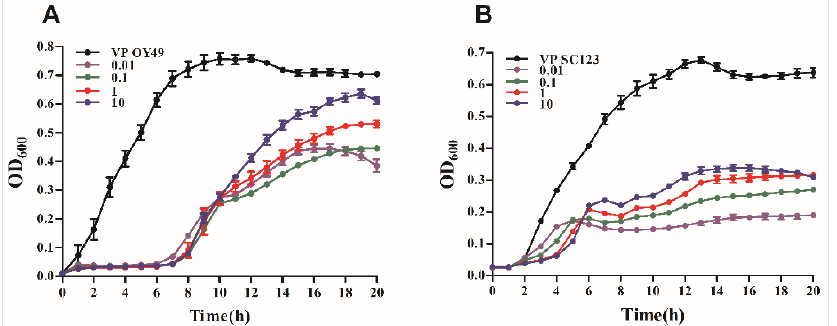
Figure 4. In vitro lysis of vB_VpaP_GHSM17 against ( A ) V. parahaemolyticus strain OY49 and ( B ) V. parahaemolyticus strain SC123 at multiplicity of infections (MOIs) 0.01, 0.1, 1, and 10 for 20 h.